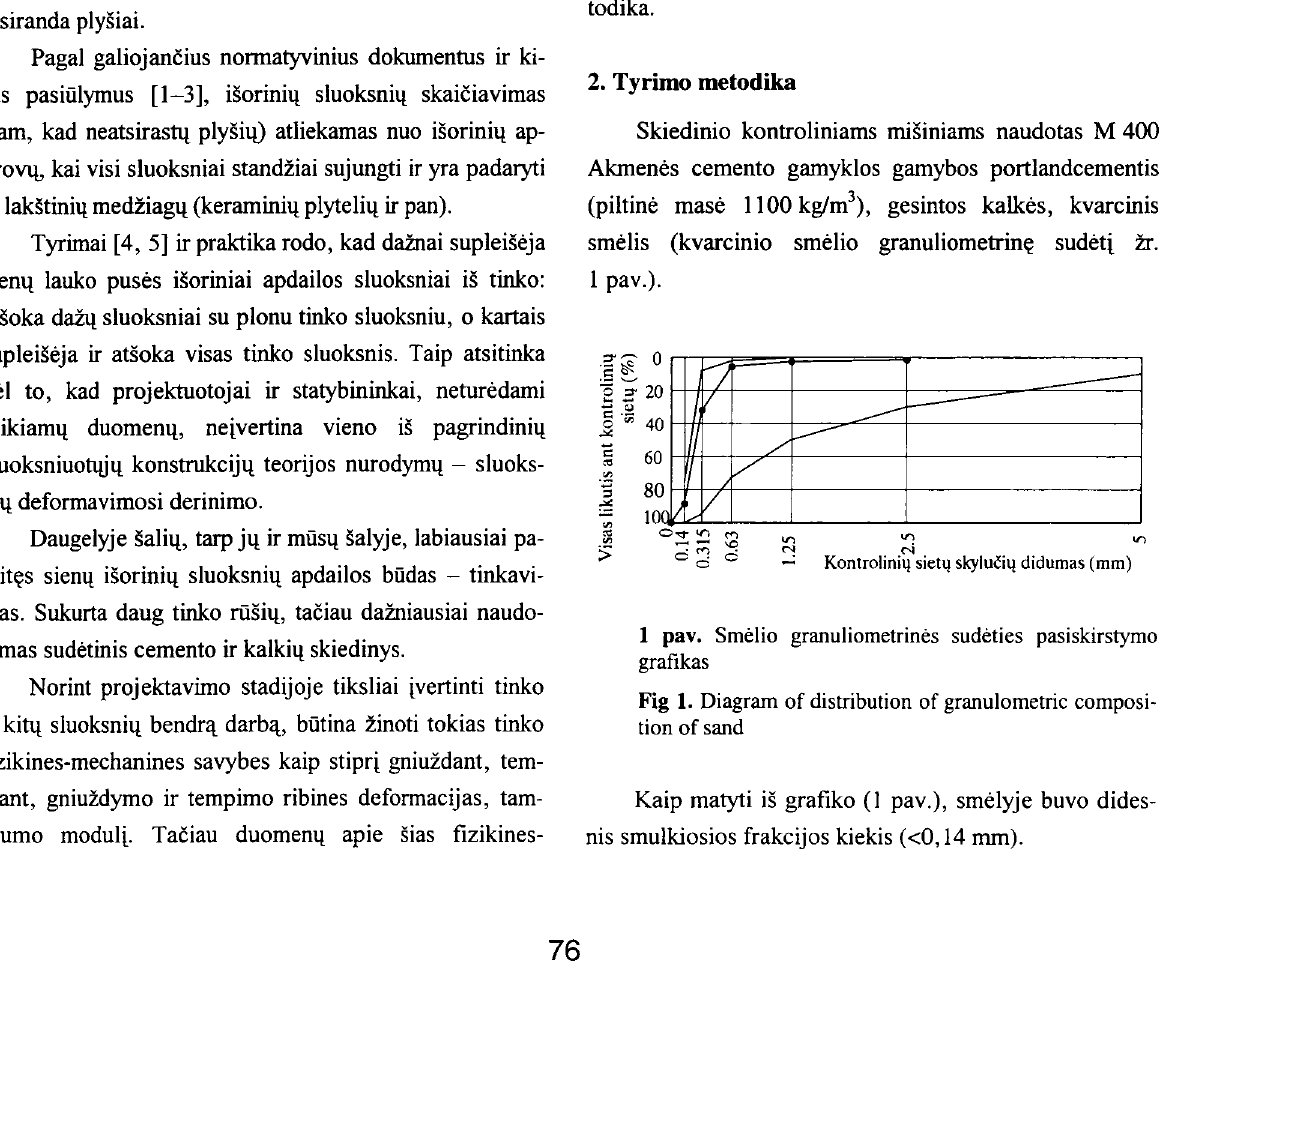
Fig 1. Diagram of distribution of granulometric composi tion of sand Kaip matyti is grafiko (I pav.), smelyje buvo dides nis smulkiosios frakcijos kiekis ( <0, 14